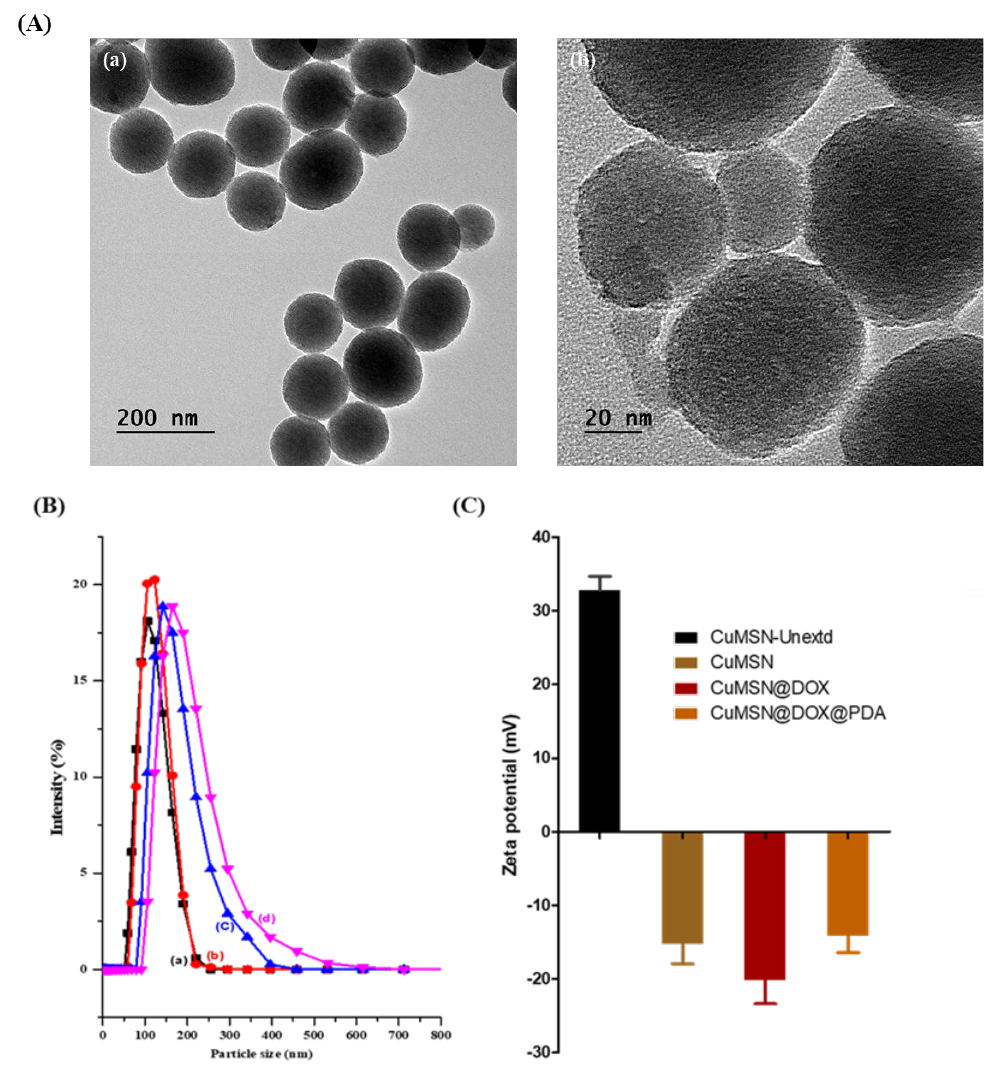
Figure 2. ( A ) TEM images of ( a ) DOX-loaded and ( b ) PDA-coated CuMSN and ( B ) hydrodynamic sizes of ( a ) CuMSN-Unextd, ( b ) CuMSN, ( c ) CuMSN@DOX, and ( d ) CuMSN@DOX@PDA. ( C ) Zeta potential charges of CuMSN and their modifications, respectively. Data represent mean ± s.d., n = 3.